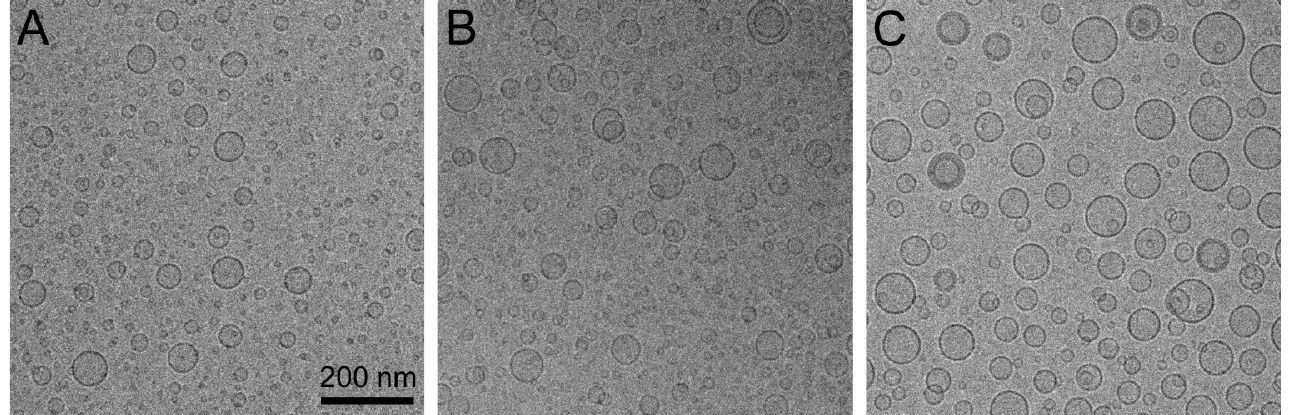
Figure 2. Cryo-TEM images of pentamidine-encapsulating ( A ) plain liposomes, ( B ) CS-liposomes and ( C ) heparin-liposomes, one month after their preparation.